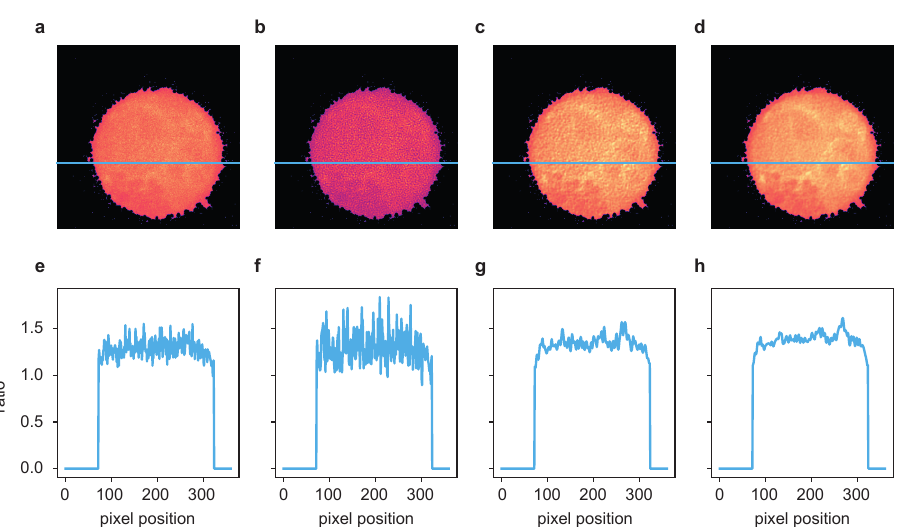
Figure 6. The ratio of the deconvolution results of the two channels from Figure 5 after postprocessing according to [2]. ( a ) Fluo-4/FuraRed ratio of raw images, ( b ) ratio of LR results, ( c ) ratio of ER results and ( d ) ratio of TD ER results. Panels ( e – h ) show the intensity profile plotted along the blue line in the frames above.